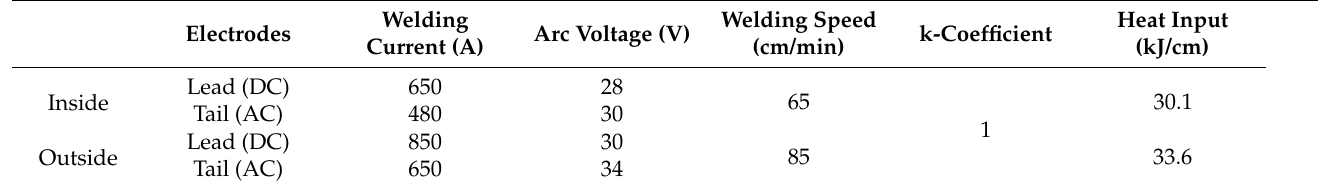
Table 2. Welding parameters and calculated heat